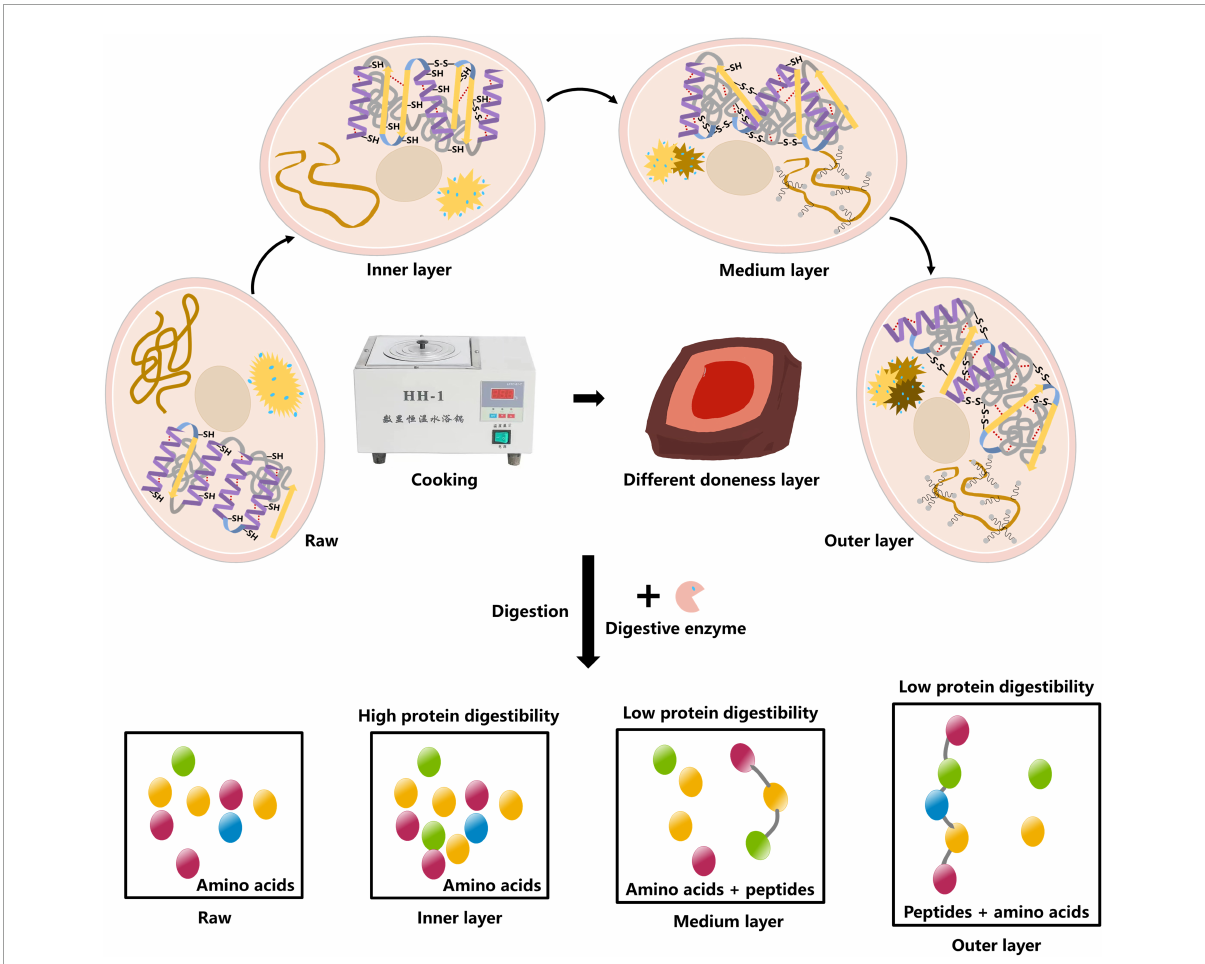
FIGURE6 Mechanistic diagram for the effect of doneness gradient on digestibility of pork